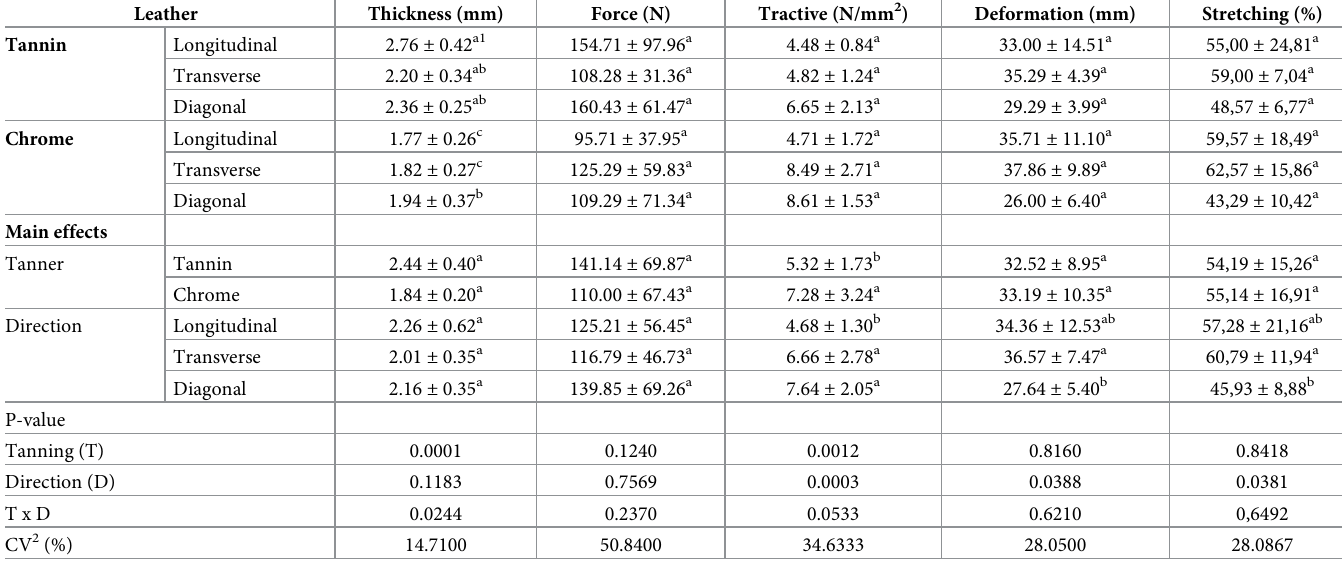
Table 2. Traction and elongation of the paiche ( A . gigas ) leathers tanned with vegetable tannin and chromium salts in longitudinal, transversal and diagonal directions.